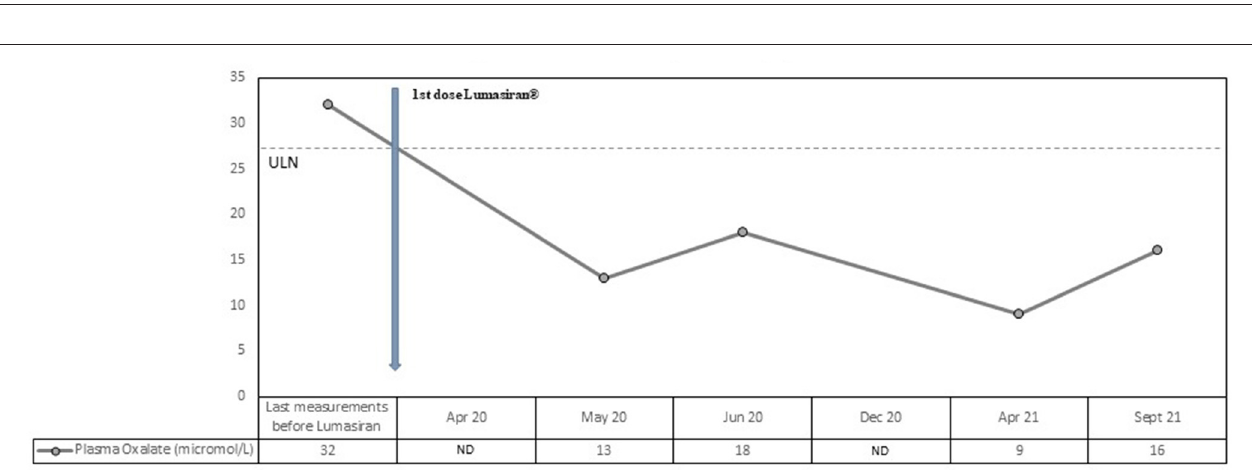
FIGURE 1 | Observed values for Urinary Oxalate/creatinine ratio from the last measurement before lumasiran to Month 18. ULN denotes upper limit of the normal range.